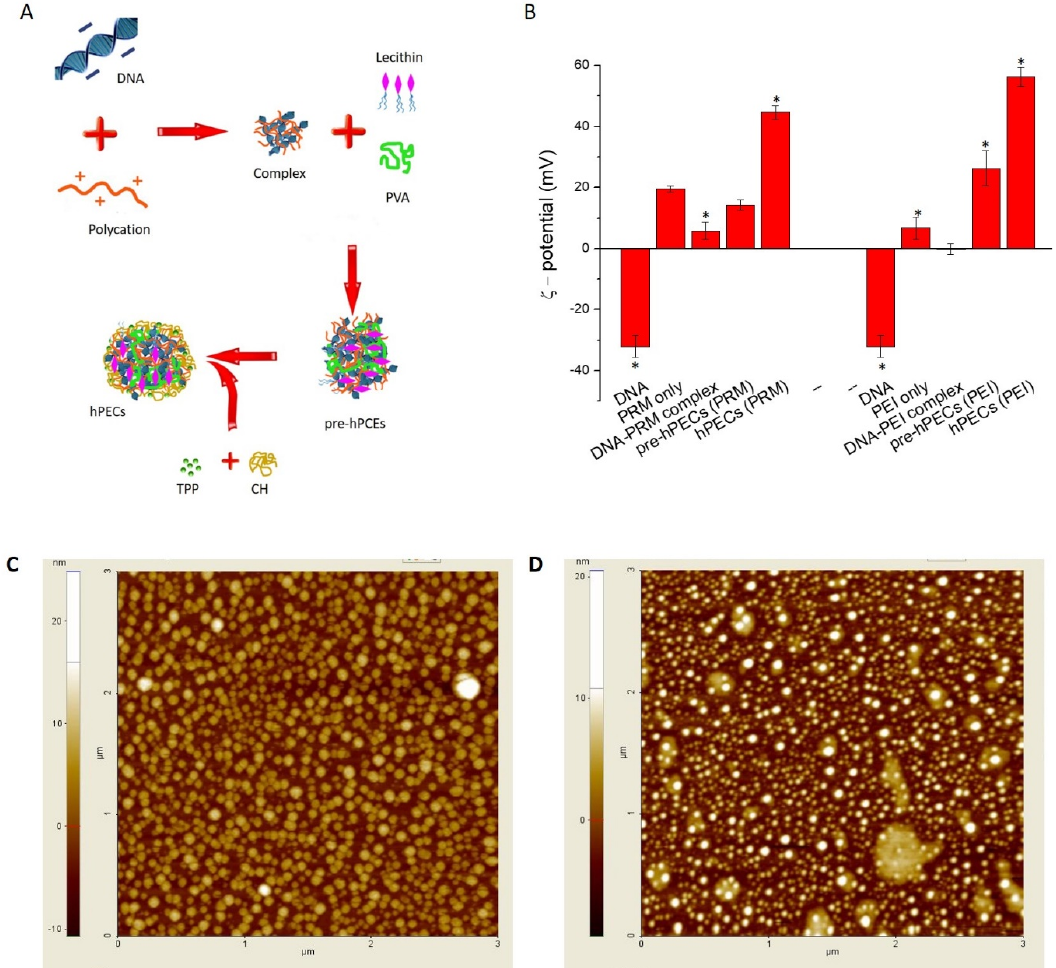
Figure 1. Schematic illustration of the synthetic procedure ( A ). In panel ( B ), mean zeta potential values of protamine-based and linear polyethyleneimine-based hPECs at each step of preparation. DNA refer to EGFP plasmids. Representative AFM images of dried PRM-hPECs ( C ) and dried PEI- hPECs ( D ). Scale bars, 1 µm. Representative measurements of three distinct sets of data, * indicates p -values of <0.05 for Student’s t- test.